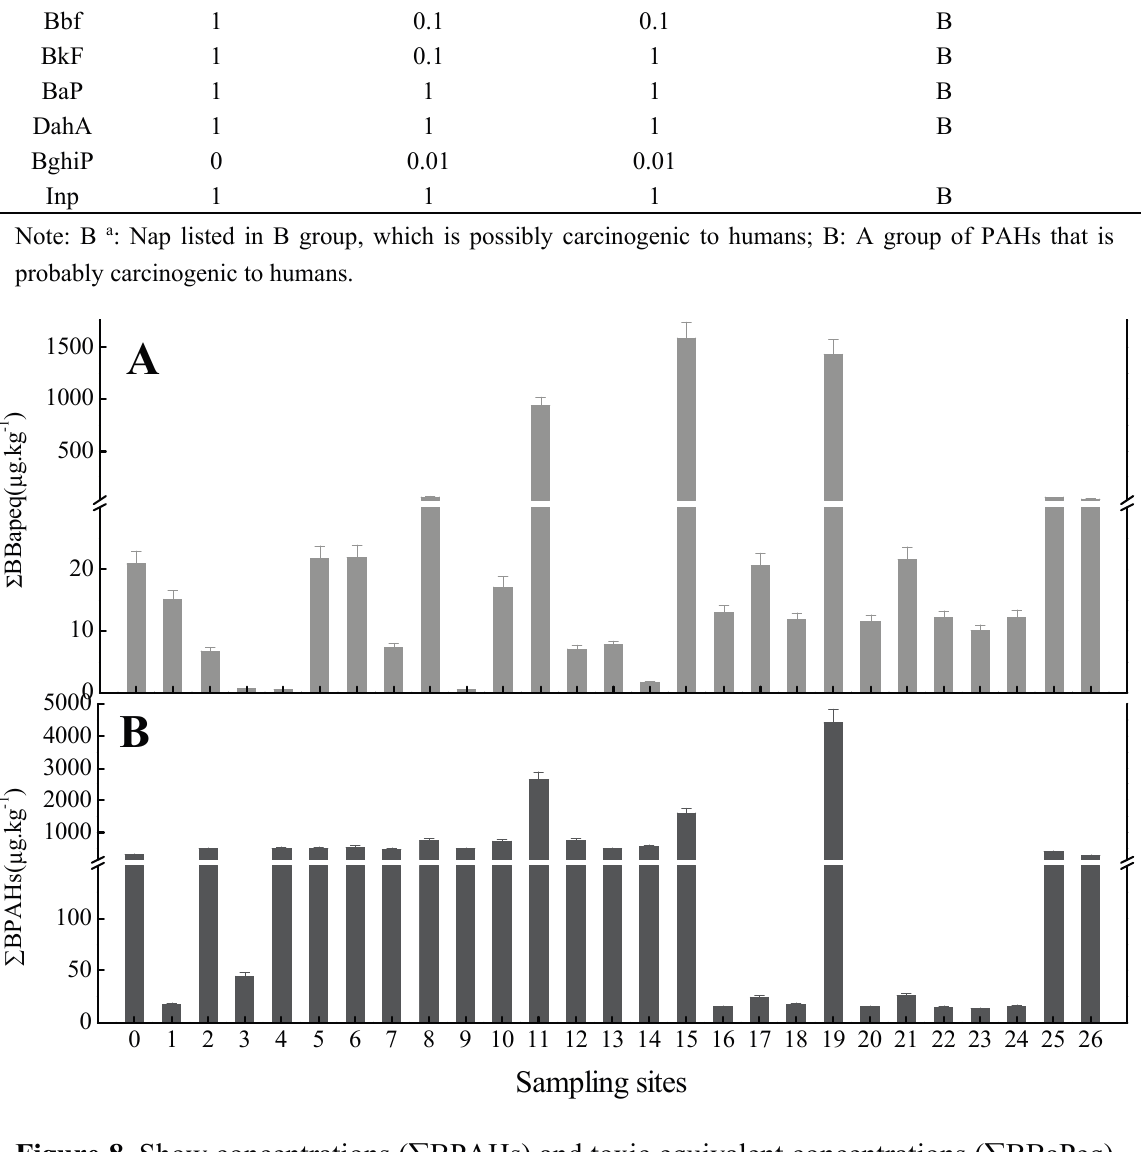
Figure 8. Show concentrations ( ∑ BPAHs) and toxic equivalent concentrations ( ∑ BBaPeq) of BPAHs in sampling sites (µg·kg − 1 ). Notes: ( A ): shows the means concentrations ( ∑ BPAHs) of BPAHs; ( B ): shows the toxic equivalent concentrations ( ∑ BBaPeq) of ∑ BPAHs; BPAHs: carcinogenic